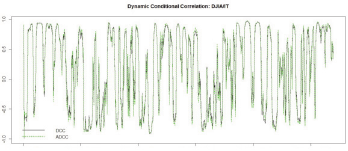
Fig. 7. Dynamic Conditional Correla- tion at D3 Scale